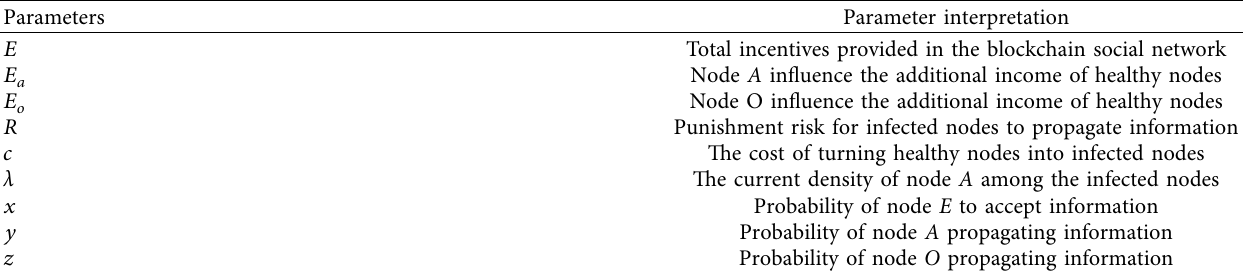
Table 2: Interpretation of Parameters in Game matrix.